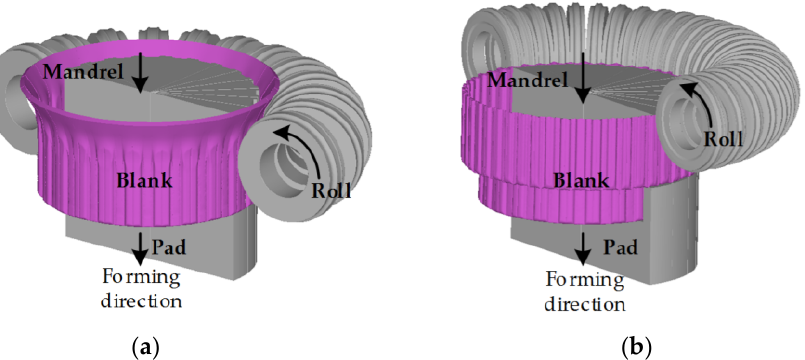
Figure 2. The schematic drawing multi-stage roll die forming (RDF) process, ( a ) 1st stage of RDF and ( b ) 2nd stage of RDF.